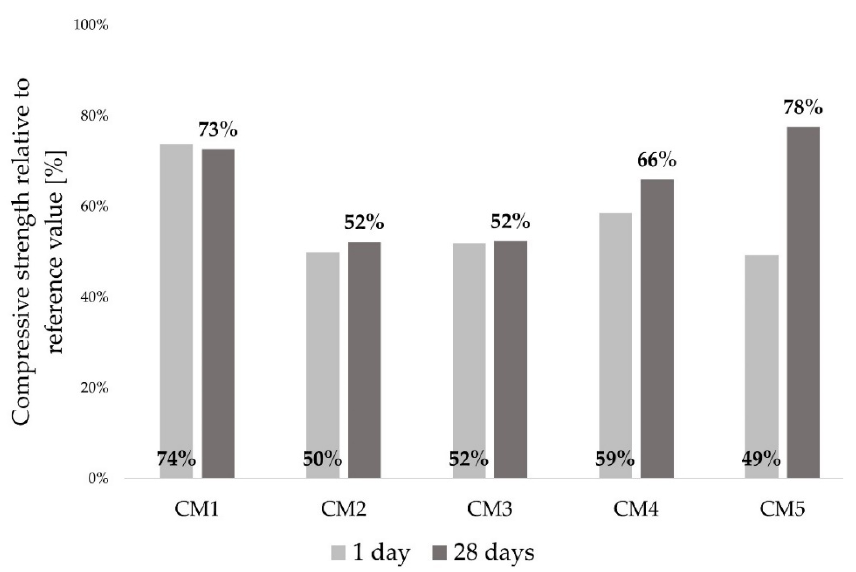
Figure 7. Compressive strength of concrete mixtures relative to the reference values after 1 and 28 days. 28